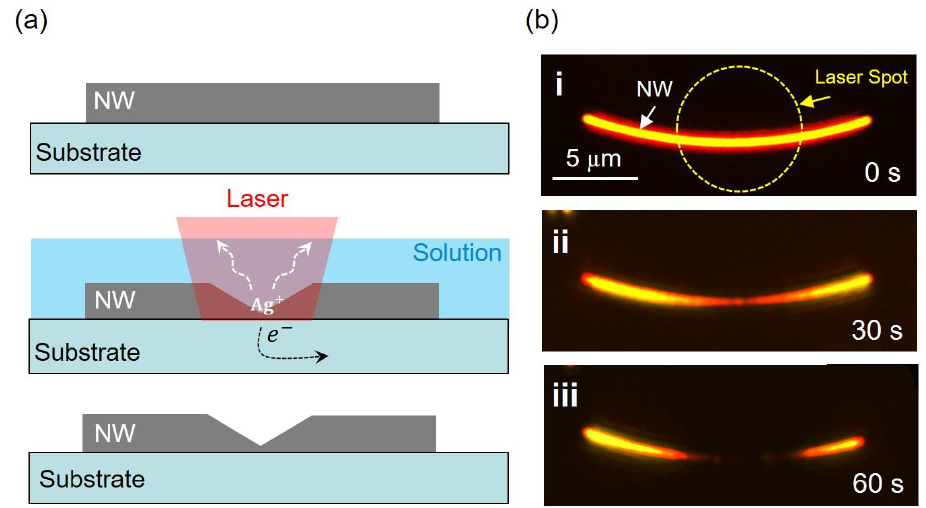
Figure 1. On-chip etching of Ag NW. ( a ) Schematic images of NW etching. ( b ) Dark field images of the etching process with illumination time ( i ) 0 s; ( ii ) 30 s; ( iii ) 60 s.